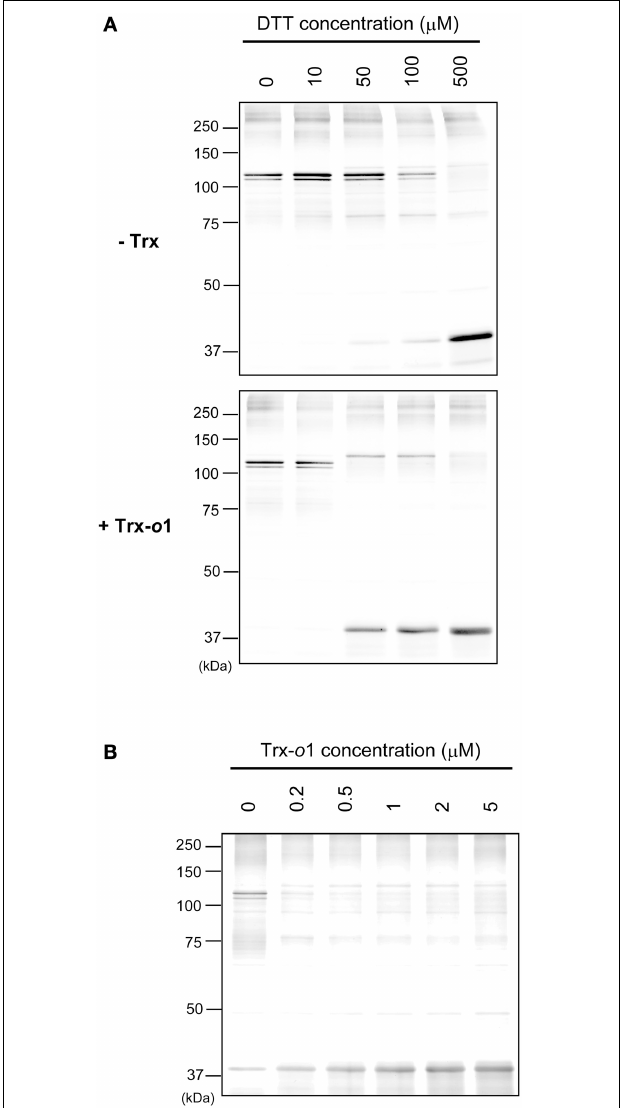
FIGURE 4 | Trx-dependent reduction of oxidized IDH-r. (A) Oxidized IDH-r was incubated in several concentrations of DTT in the absence (upper panel) or presence (lower panel) of 5 μ M Trx- o 1 for 30min. (B) Oxidized IDH-r was incubated in several concentrations of Trx- o 1 in the presence of 50 μ M DTT for 30min. The redox state of IDH-r was assayed by non-reducing SDS-PAGE.